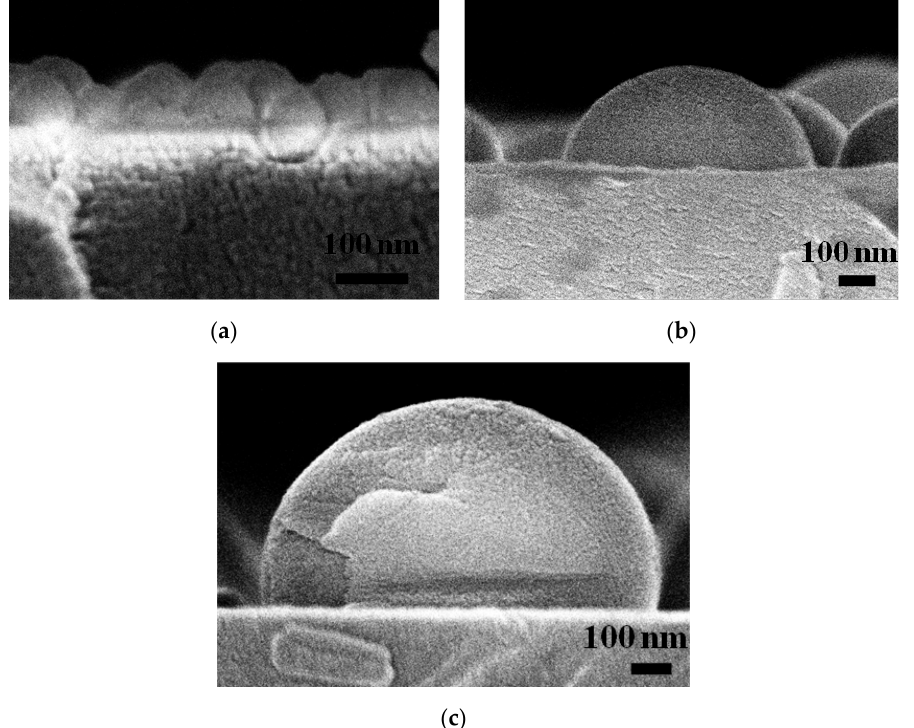
Figure 2. Cross-sectional images of Ag particles with different sizes of ( a ) 92 nm, ( b ) 570 nm and ( c ) 1.2 µ m.